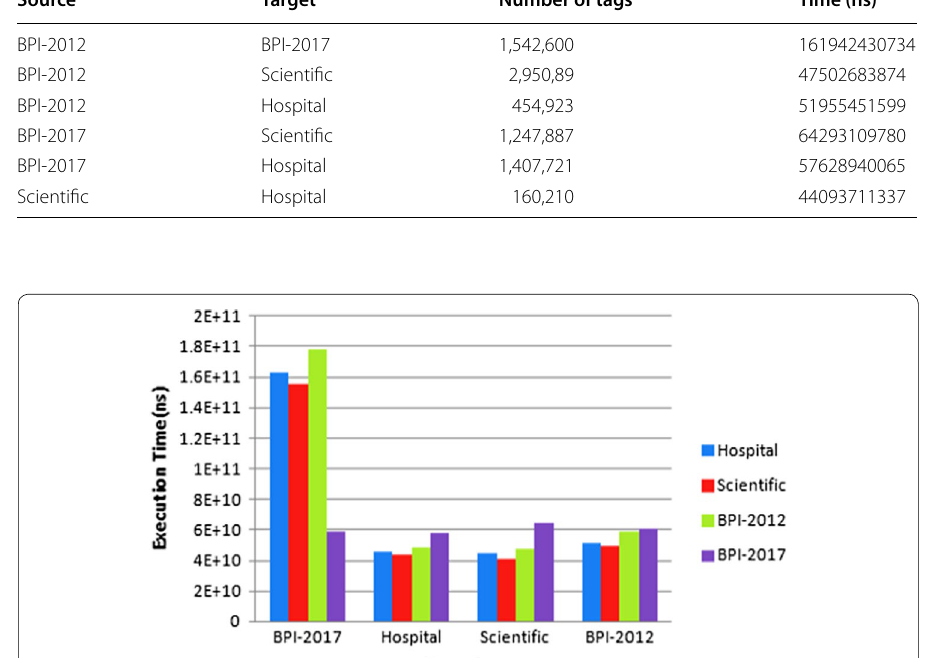
Fig. 5 Processing time of CDCE for different dataset sizes.Vertical axes shows time